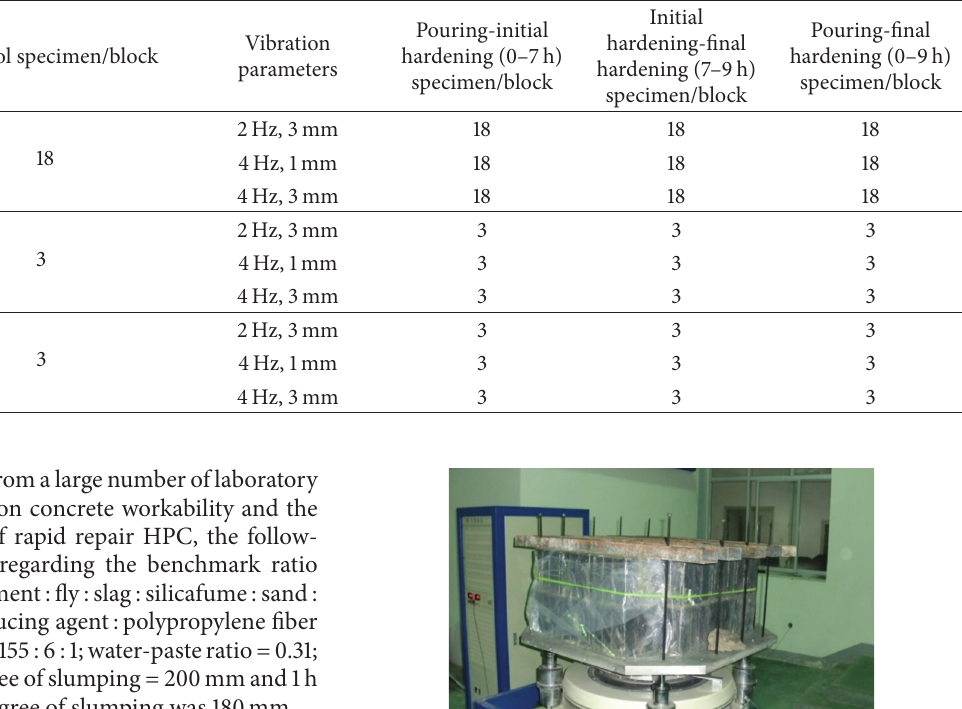
Table 1: Experimental groupings.